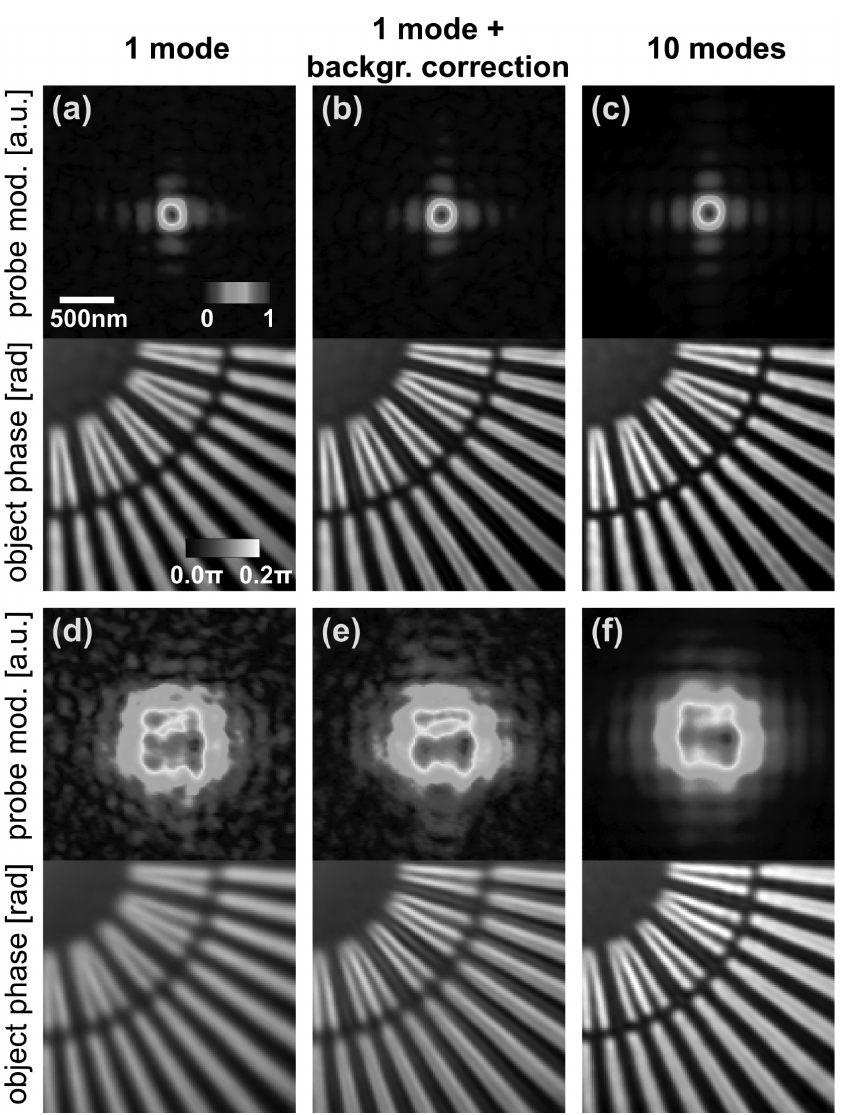
Figure 3. Comparison between three reconstruction strategies: conventional reconstruction ( a , d ); reconstruction after background correction on diffraction data ( b , e ); and mixed-state reconstruction using 10 modes ( c , f ). For each frame, the image on the top displays the modulus of the retrieved probe and the image on the bottom is the phase of the reconstructed object. ( a , c ) (resp. ( d , f )) Reconstructions from the scan at a distance of +0.35 mm (resp. +2.1 mm) from the focus of the illumination. The colour scale for all panels is the same as in ( a ). Figure adapted from Ref [13]. Reprint permission granted. 2014 American Institute of